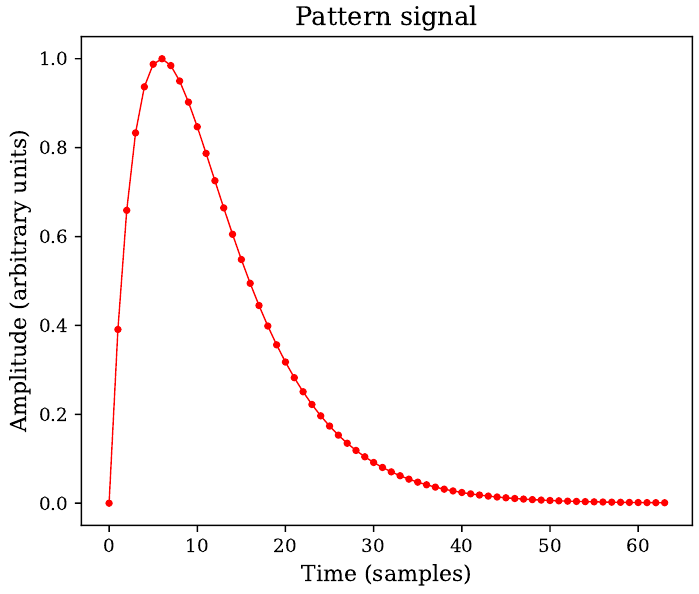
Figure 1. Example of a pattern signal used as template, comprised by 64 successive